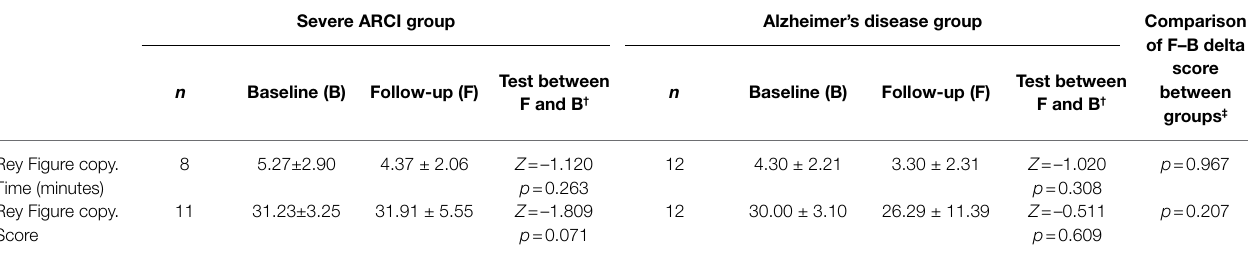
TABLE 5 | Results of cognitive tests of visuo-spatial abilities at baseline (B) and follow-up (F) in severe Alcohol-Related Cognitive Impairment (severe ARCI) group ( n = 15) and in Alzheimer’s disease group ( n = 12). Severe ARCI